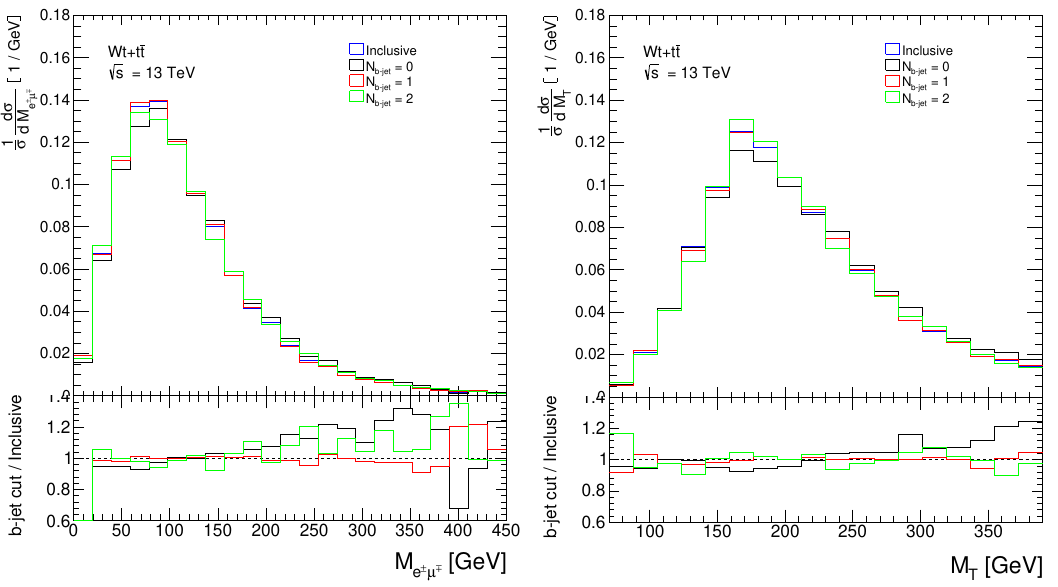
Figure 9 . Leptonic distributions produced by tt and tW processes (see text) as a function of the b - tagged jet multiplicity. The di-lepton invariant mass (left) and the transverse mass of the di-lepton and missing transverse energy system are displayed. Distributions are normalised to unity. The insert shows the ratio of the distributions with exclusive b -tagged jet bins relative to that obtained